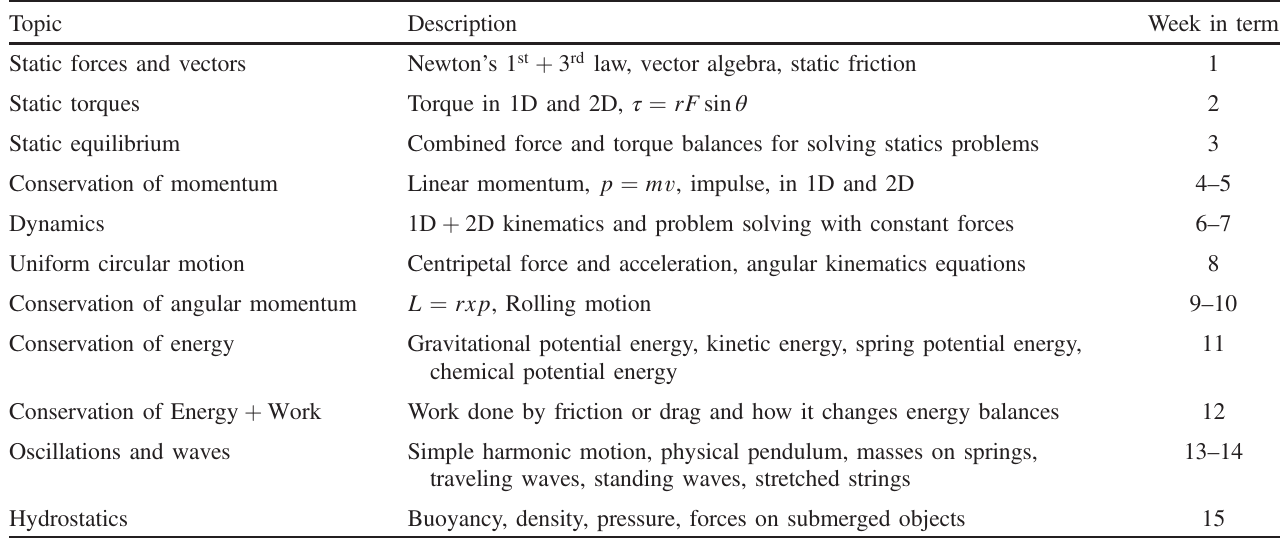
TABLE IV. List of topics and content covered at Auburn.